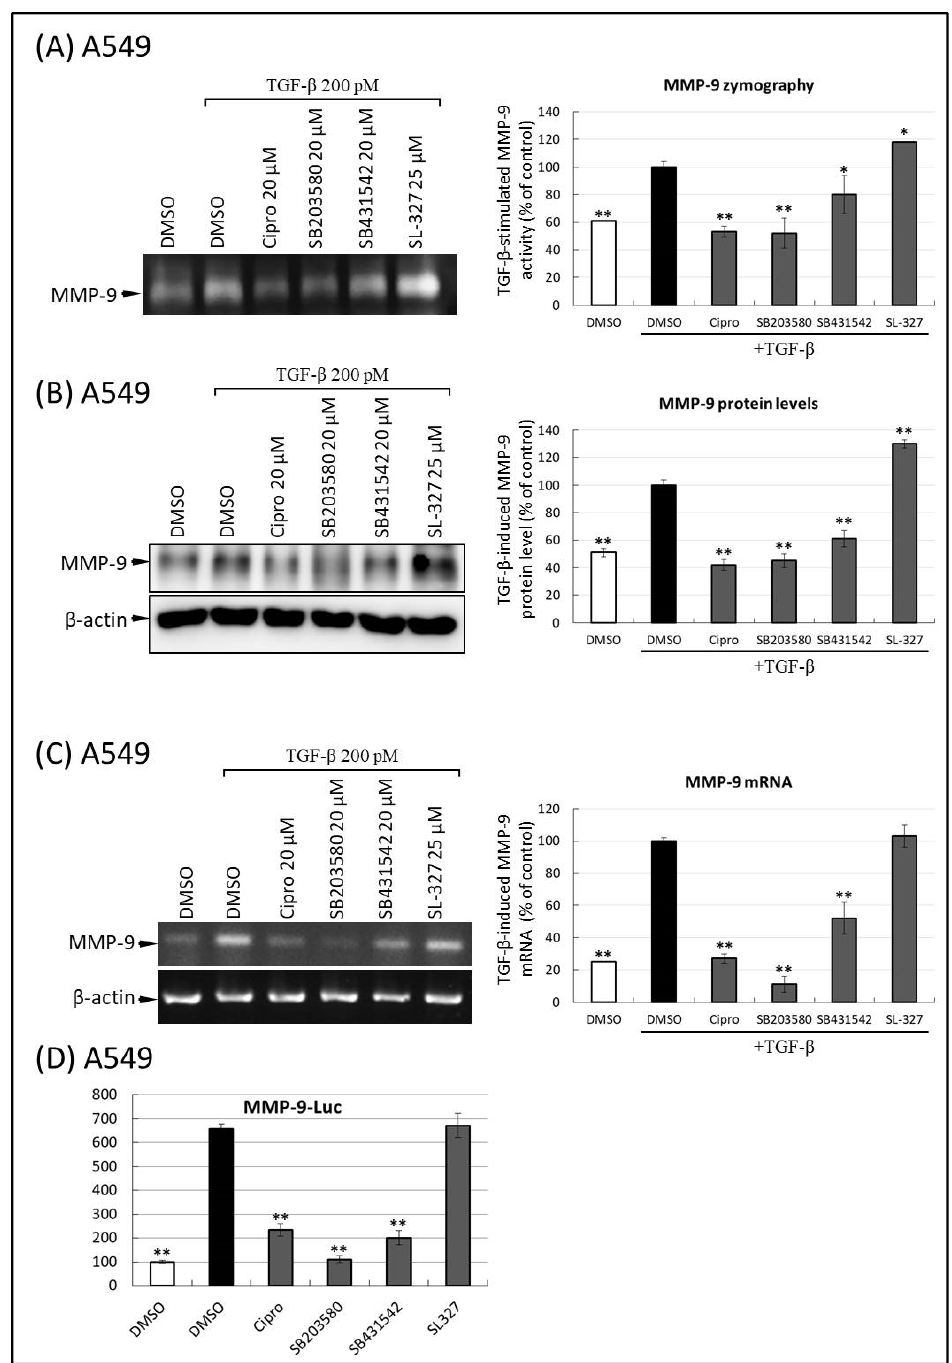
Figure 6. Ciprofloxacin, p38 inhibitor, and transforming growth factor beta (TGF- β ) receptor-I inhibitor, but not MEK inhibitor, inhibit matrix metalloproteinase-9 (MMP-9) activity, secretion, and transcriptional activity. ( A ) Ciprofloxacin, p38 inhibitor (SB203580), and TGF- β inhibitor (SB431542) inhibit TGF- β -stimulated gelatinolytic activity of MMP-9 in A549 cells. The conditioned mediums from a similar treatment described in Figure 2A were subjected to gelatin zymography analysis of MMP-9. The conditional mediums from chemical-treated cells were subjected to zymographic analysis of MMP-9. An equal amount of protein loading was verified using a bicinchoninic acid protein assay; the right-hand graph illustrates quantitative analysis (mean ± standard deviation [SD]) from three independent experiments (compare with TGF- β treatment alone); * p ≤ 0.05, ** p ≤ 0.01. ( B ) Ciprofloxacin, SB203580, and SB431542 prevent TGF- β -induced MMP-9 protein expression in A549. The samples from a similar treatment described in Figure 3 were subjected to immunoblot analysis of MMP-9 and β -actin. An equal amount of protein loading was verified using β -actin; the right-hand